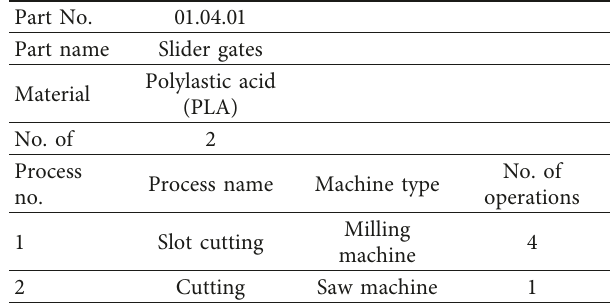
Table 12: Pinion.